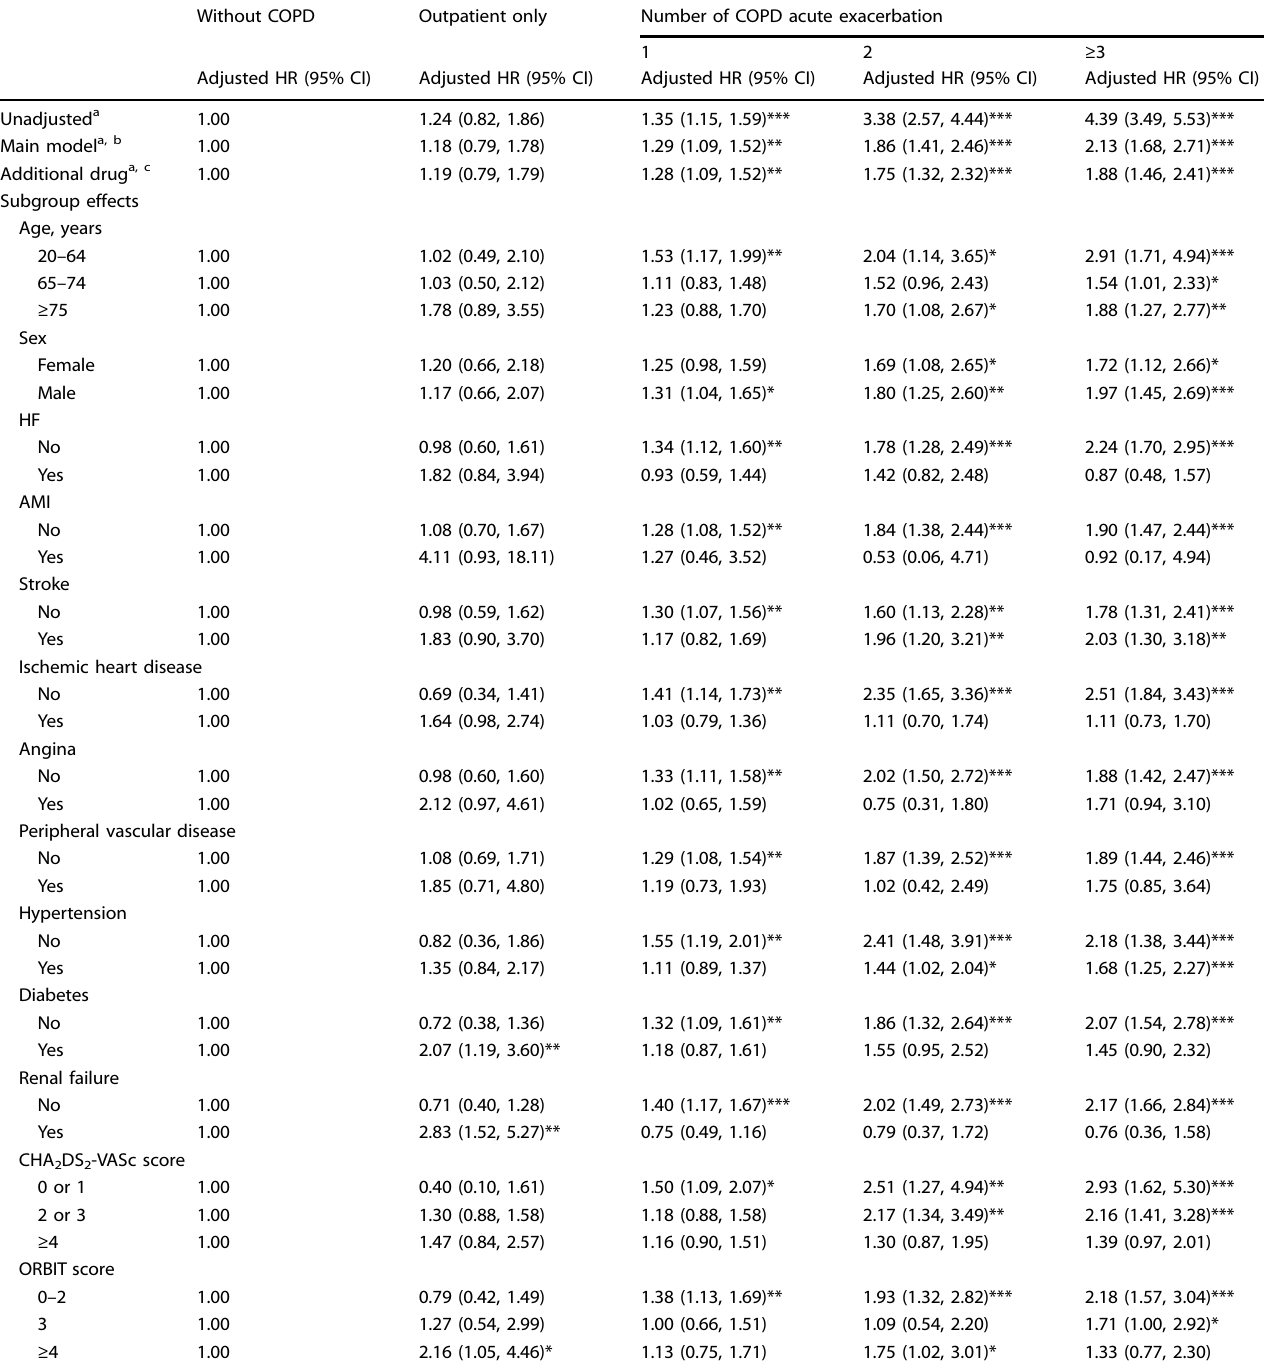
Table 3. Risk of lethal VA for frequencies of acute COPD exacerbation. Without COPD Outpatient